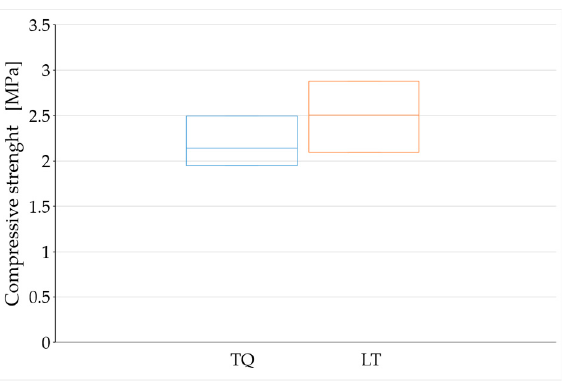
Figure 14. Minimum, average, and maximum values of compressive strength after 450 days of cur- ing.